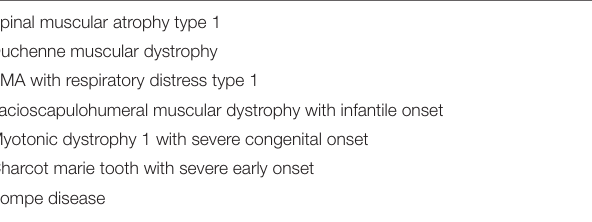
TABLE 1 | Neuromuscular diseases with recurrent pneumonia. Spinal muscular atrophy type